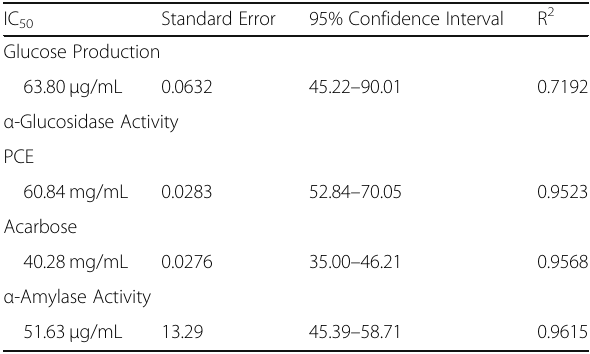
Table 2 In vitro study